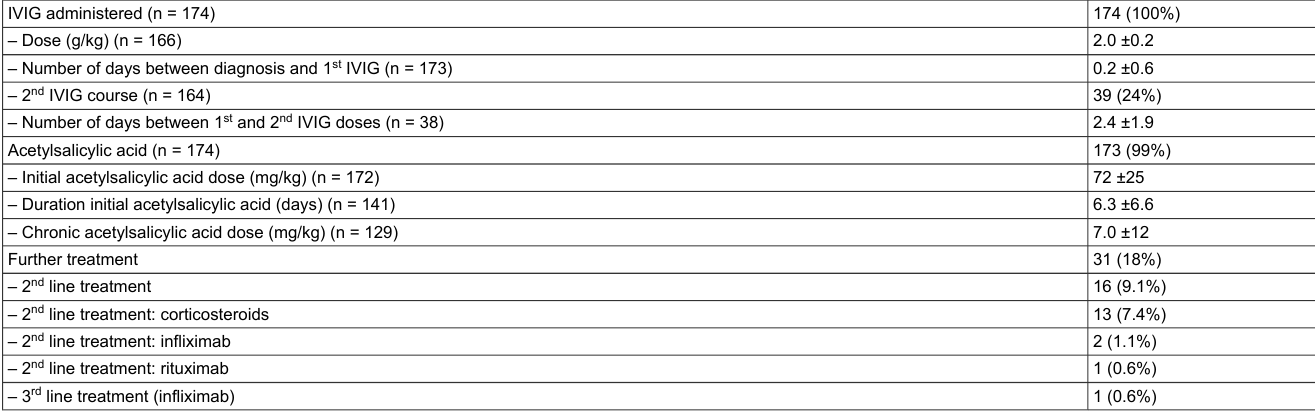
Table 2: Treatment. Continuous variables are expressed as mean and standard deviation (SD). Categorical variables are expressed as absolute number and percentage. All patients: n = 175.